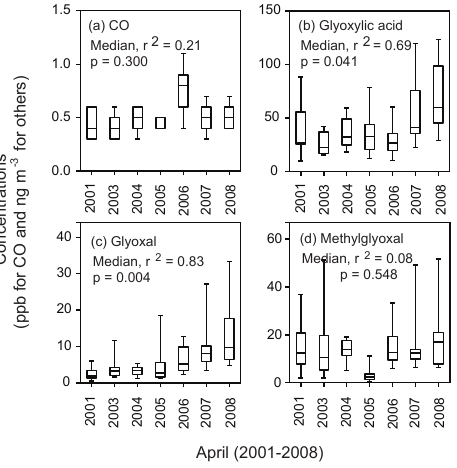
Figure 9. Boxplots depicting interannual (2001–2008) trends in April: (a) carbon monoxide (CO), (b) glyoxylic acid ( ω C 2 ) , (c) gly- oxal (Gly), and (d) methylglyoxal (MGly). The trends in interannual variations for the other months are shown in Table S2. The lower, middle, and upper lines in the box represent the 25th, 50th and 75th percentiles, respectively. The lower and upper whiskers represent the 10th and 90th percentiles, respectively. The r 2 values were cal- culated based on the median concentrations using a linear regression